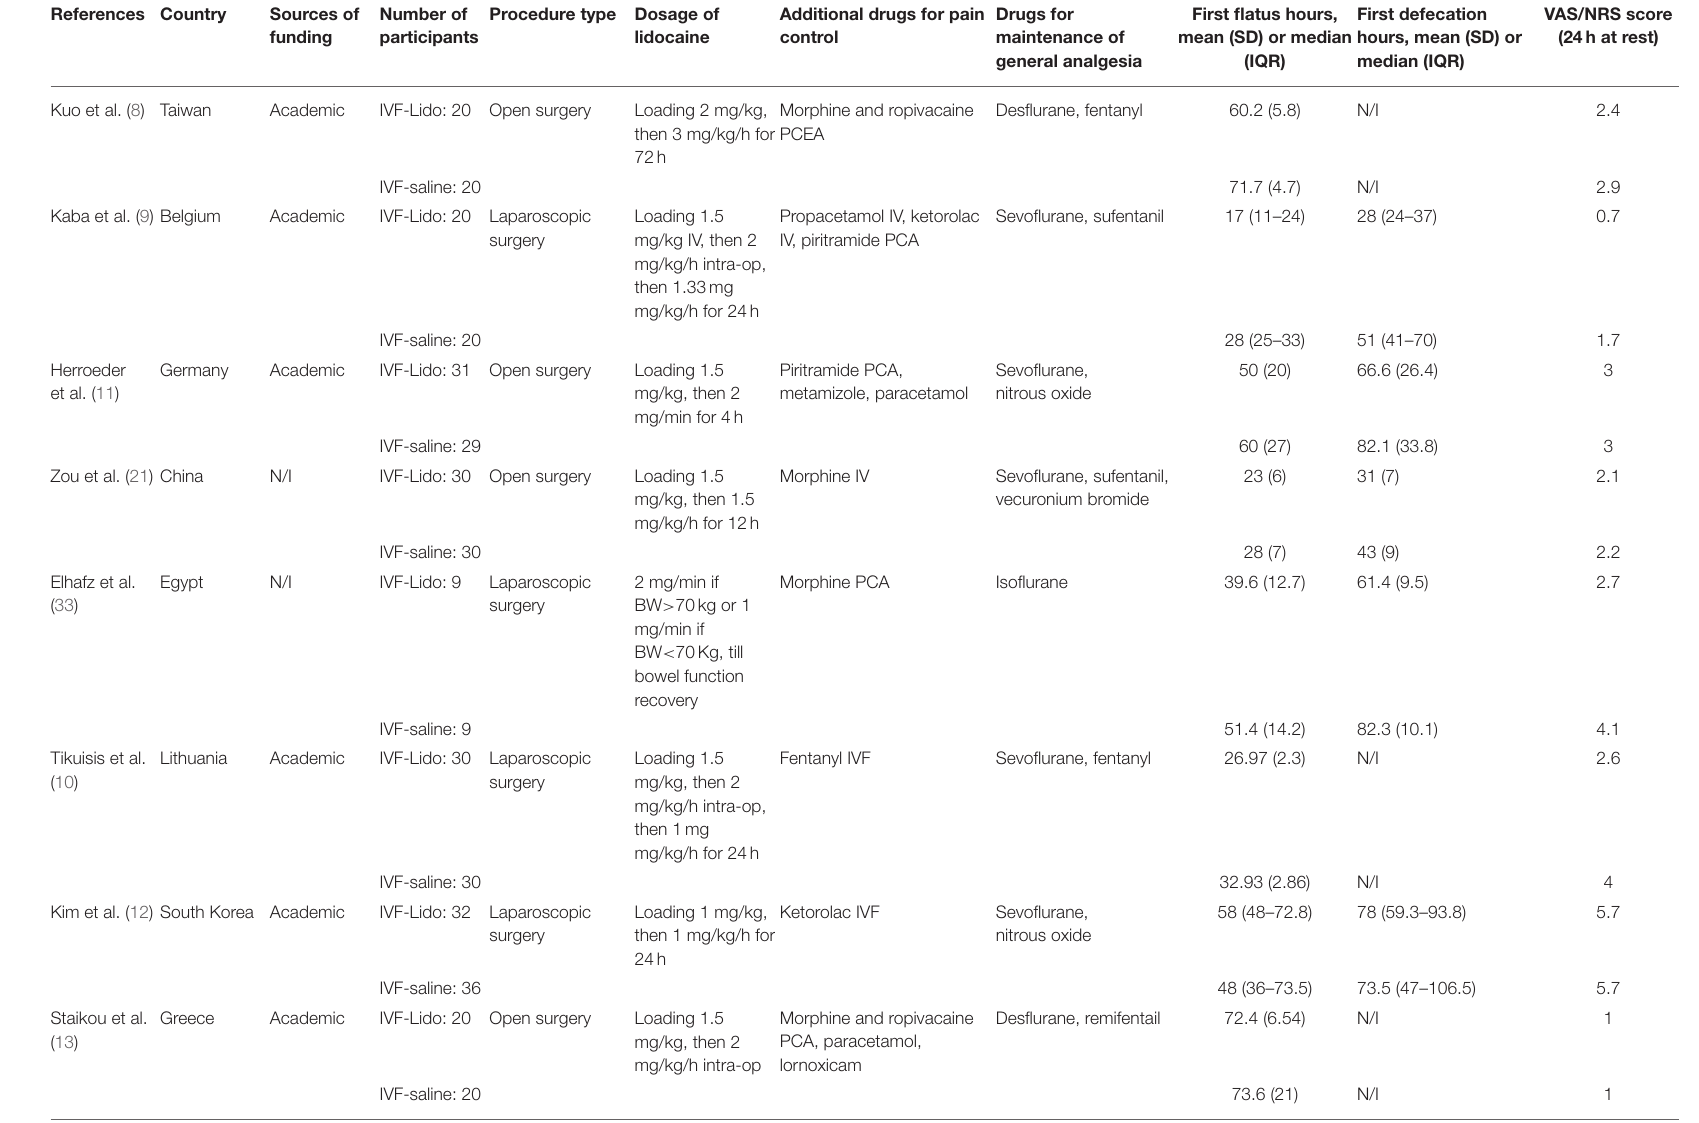
TABLE 1 | Details of RCTs included in our